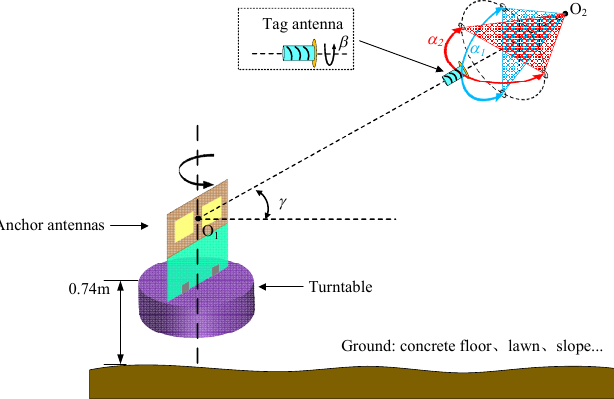
Figure 13. Overview of the proposed antenna system for localization.